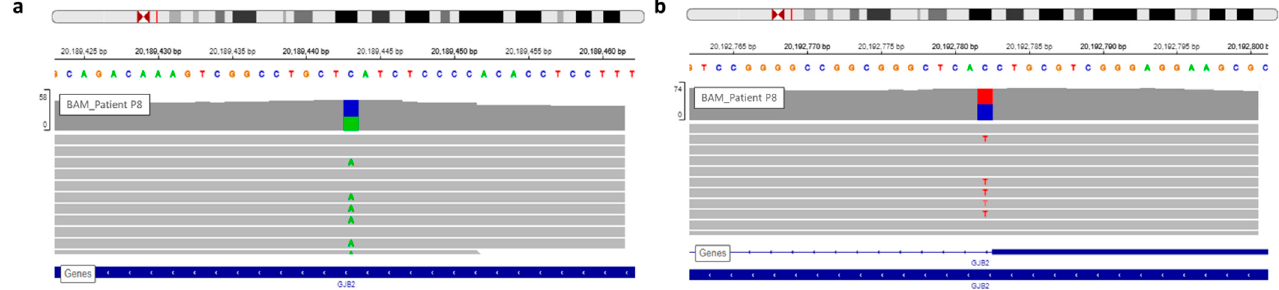
Figure 4. View of GJB2 variants of patient P8 in IGV. ( a ) The nonsense variation, c.139G > T, discovered during routine care. ( b ) The second GJB2 variation detected by WGS analysis is a splice site mutation.